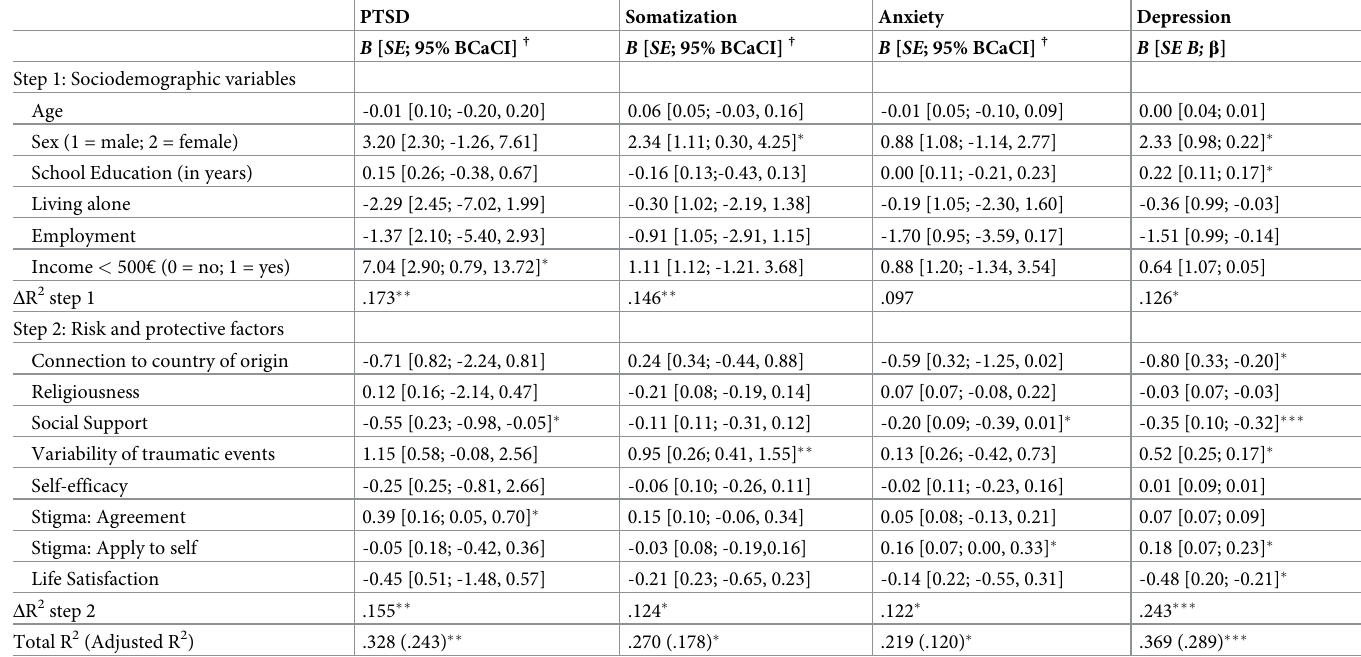
Table 3. Results from multiple linear hierarchical regression analysis (Model